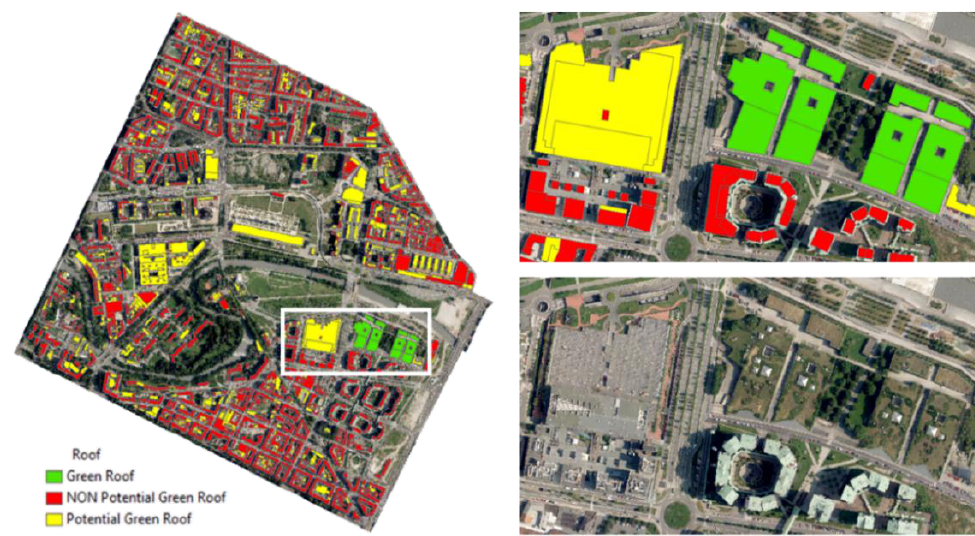
Figure 15. Identification of the existing and potential green roofs in the EnviPark area. Table 9. Identification of existing and potential green roofs in the eight areas of Turin.